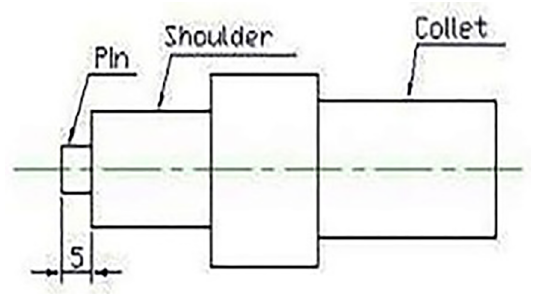
Figure 1 . Schematic view of FSW/SFSW